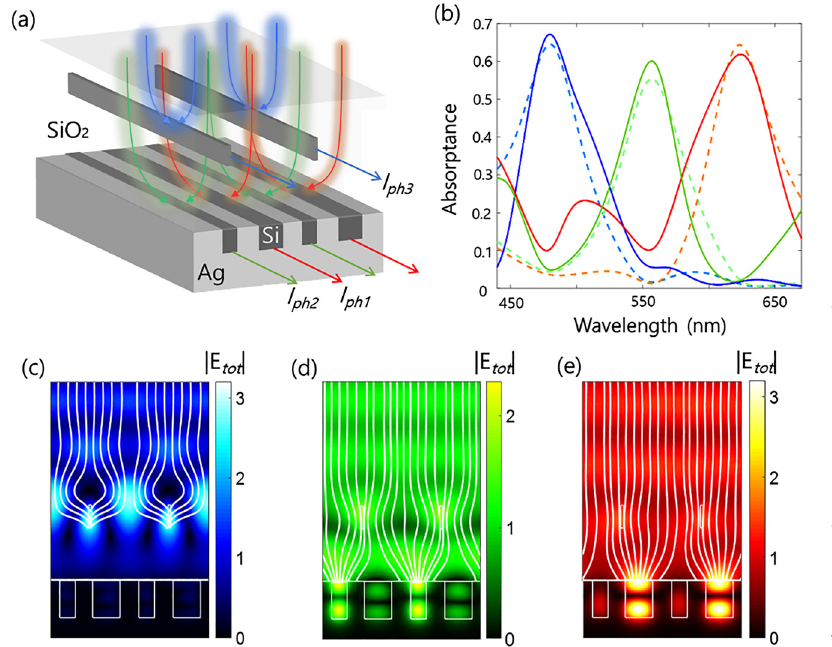
imaginary [30, 31]. Such model is indicated as dashed line in Figure 4b and closely follows the full- fi eld simulations. More intriguing than the strong light absorption is the enhancement of the absorption cross-section of nano- beams [46]. For example, the narrow beams at top occupy only 3.3% of the total geometric cross-sectional area. Such narrow beams effectively capture most of the incident light, and virtually signi fi cantly shadow the bottom meta- surfaces, as illustrated in the optical fi eld with power fl ow lines (Figure 4c). Similarly, incident light with green and red spectra avoids the top nanobeams, and is effectively absorbed in the target nanobeam arrays, as illustrated in Figure 4d and e.